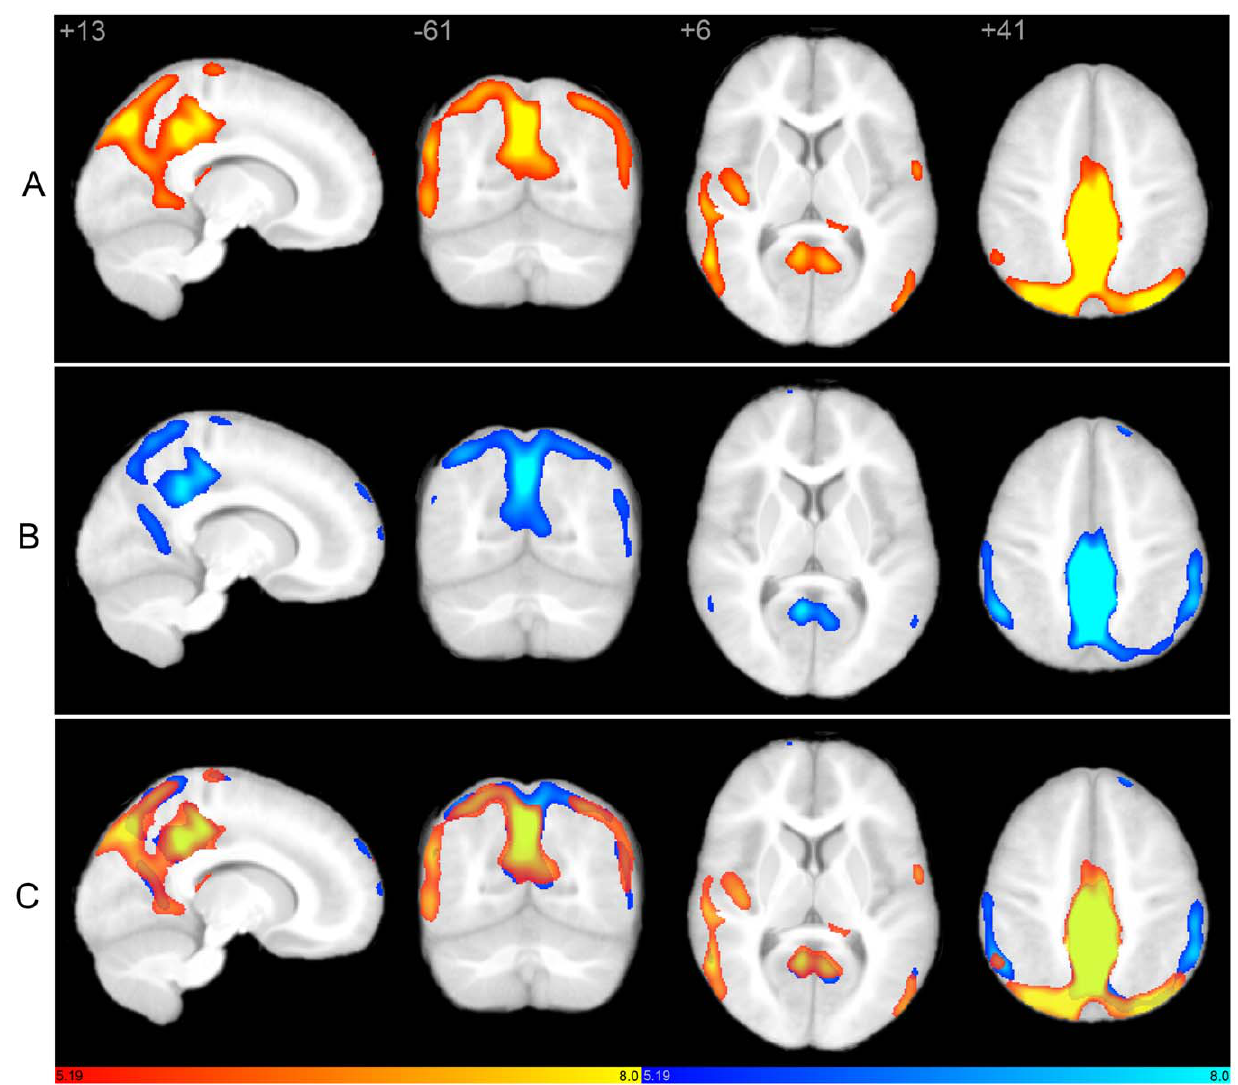
Figure 2. Structural covariance maps of the default mode network in autism and controls. Statistical parametric maps depict brain regions in which gray matter intensity covaried with that of the seed ROI (right PCC) in each group. (A) Structural covariance patterns appear robust in posterior brain regions, but restricted in frontal areas in autism (hot colors; see also Table 2). Covariance outside of canonical DMN boundaries is also evidenced. (B) Corresponding scMRI map in normal controls corresponds to a robust canonical default mode network (cool colors). (C) scMRI maps from both groups overlaid on a single anatomic volume. scMRI data are T-statistic maps (p , 0.01, FWE-corrected) displayed on the average anatomical template of all subjects. The left side of the image corresponds to the right side of the brain. DMN, default mode network; FWE, family- wise error; PCC, posterior cingulate cortex; ROI, region of interest; scMRI, structural covariance MRI. doi:10.1371/journal.pone.0049172.g002 within right superior frontal gyrus and medial frontal cortex superior temporal gyrus, right frontal operculum including inferior (Figure 2), corresponding to canonical DMN topology [39–41]. frontal gyrus, bilateral caudate body, and left orbitofrontal cortex. Total network volume was increased in autism versus controls (Figure 3). Peak clusters and coordinates are depicted in Table 2.